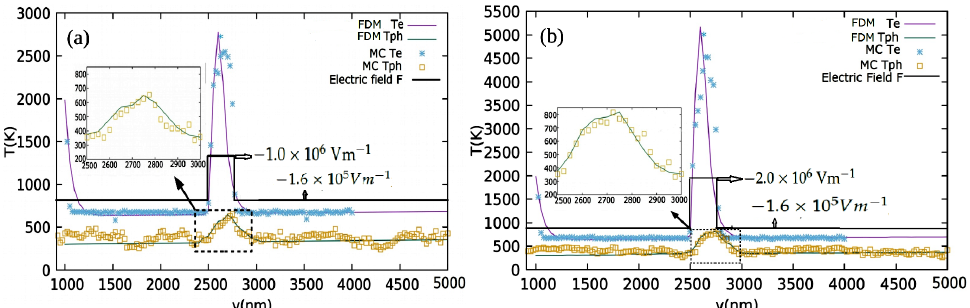
Figure 4. ( a ) Electron and phonon temperatures ( T e and T ph ) along the y direction using the MC and the two step model (FDM) for the non-uniform electric field ( (cid:126) F = − 1.0 × 10 6 Vm − 1 ˆ y ) peaking at 2500–2800 nm. A sharp peak in T e is observed in the high electric field region and a corresponding rise in T ph is magnified and separately shown as inset. ( b ) Electron and phonon temperatures along the y direction using MC and two step model (FDM) for non-uniform electric field ( (cid:126) F ( y ) = − 2.0 × 10 6 Vm − 1 ˆ y ) peaking at 2500–2800